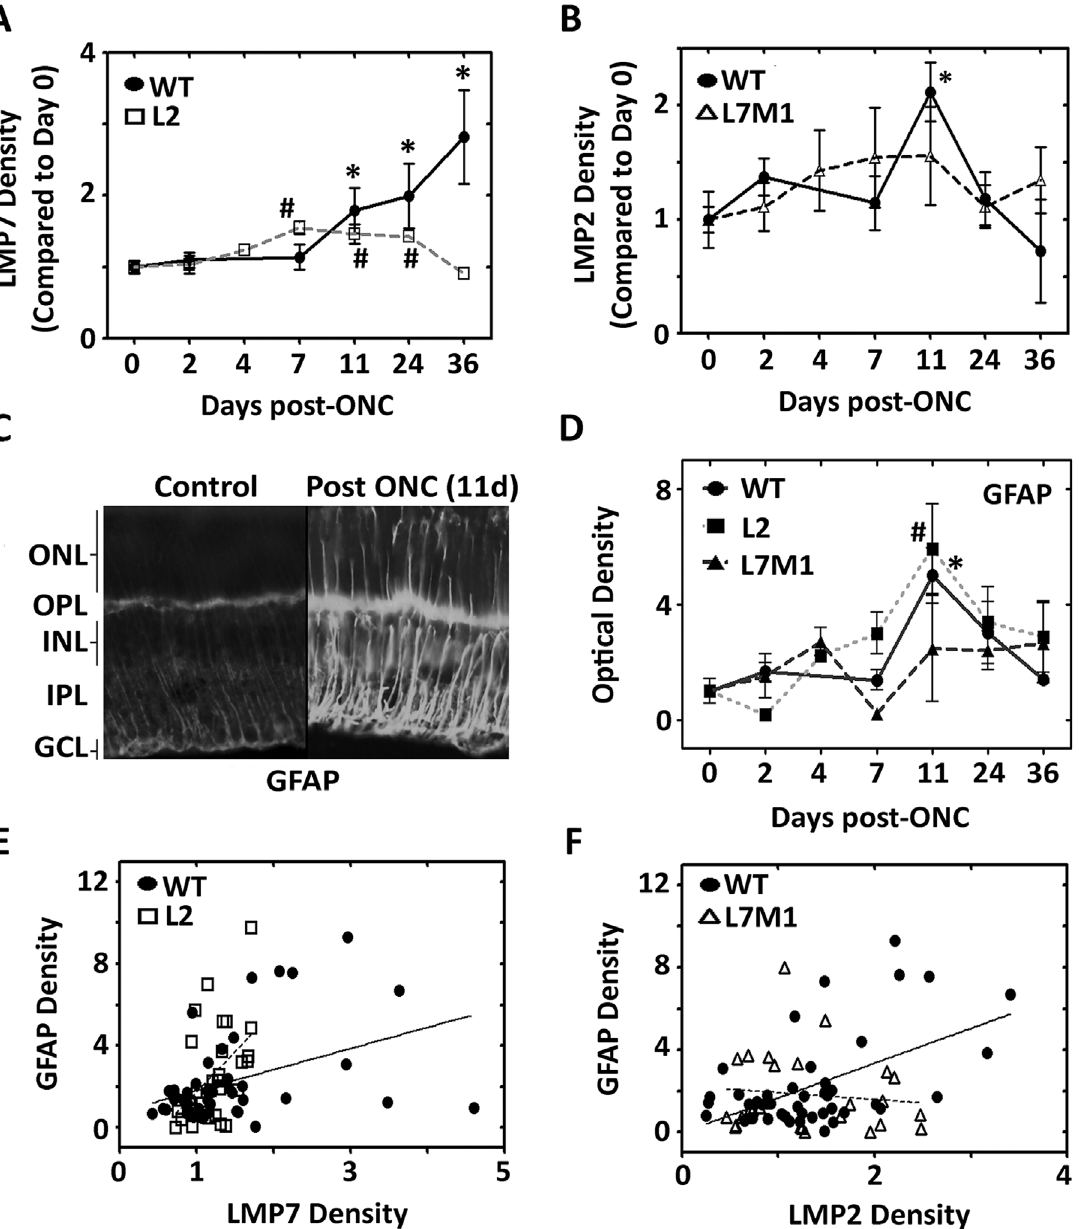
Fig 2. Optic Nerve Crush Increases Stress and Correlates with an Increase in Immunoproteasome Subunits in WT Retina. ( A and B ) Protein was isolated from WT ( ● ), L2 ( □ ), and L7M1 ( Δ ) mouse retinas at the indicated time points after ONC. Results are the optical density of immunoproteasome subunits ( A ) LMP7 ( β 5i) and ( B ) LMP2 ( β 1i), and are the mean ± S.E. of 3 – 22 ** mice/group compared to control (day 0). ( * , p (cid:1) 0.05 (WT), and #, p (cid:1) 0.01 (L2) by one-way ANOVA with Dunnett ’ s post-test compared to the ‘ day 0 ’ values). ( ** All 36 day WT mouse data represents 2 mice/group). ( C ) WT retina tissue sections stained with anti-GFAP in WT retina before and after optic nerve crush (11 days). Image was taken with a 40x objective. ( D ) Protein was isolated from WT ( ● ), L2 ( ■ ), and L7M1 ( ▲ ) retinas at the indicated time points after ONC. Results are the optical density of the GFAP protein content, and are the mean ± S.E. of 3 – 15 mice/group compared to control (day 0) for each mouse strain. ( * , p (cid:1) 0.001 (WT), #, p (cid:1) 0.01 (L2) by one-way ANOVA with Dunnett ’ s post-test compared to the ‘ Day 0 ’ values). ( E ) GFAP and LMP7 protein content isolated from WT ( ● ) or L2 ( □ ) mice are shown as a correlation. (R 2 = 0.2292; p (cid:1) 0.01 (WT), R 2 = 0.1620; p (cid:1) 0.01 (L2), by Pearson Correlation). ( F ) GFAP and LMP2 protein content from WT ( ● ) or ( Δ ) L7M1 mice are shown as a correlation. (R 2 = 0.2860; p (cid:1) 0.001 (WT), R 2 = 0.0126, p = 0.57 (L7M1), by Pearson Correlation).